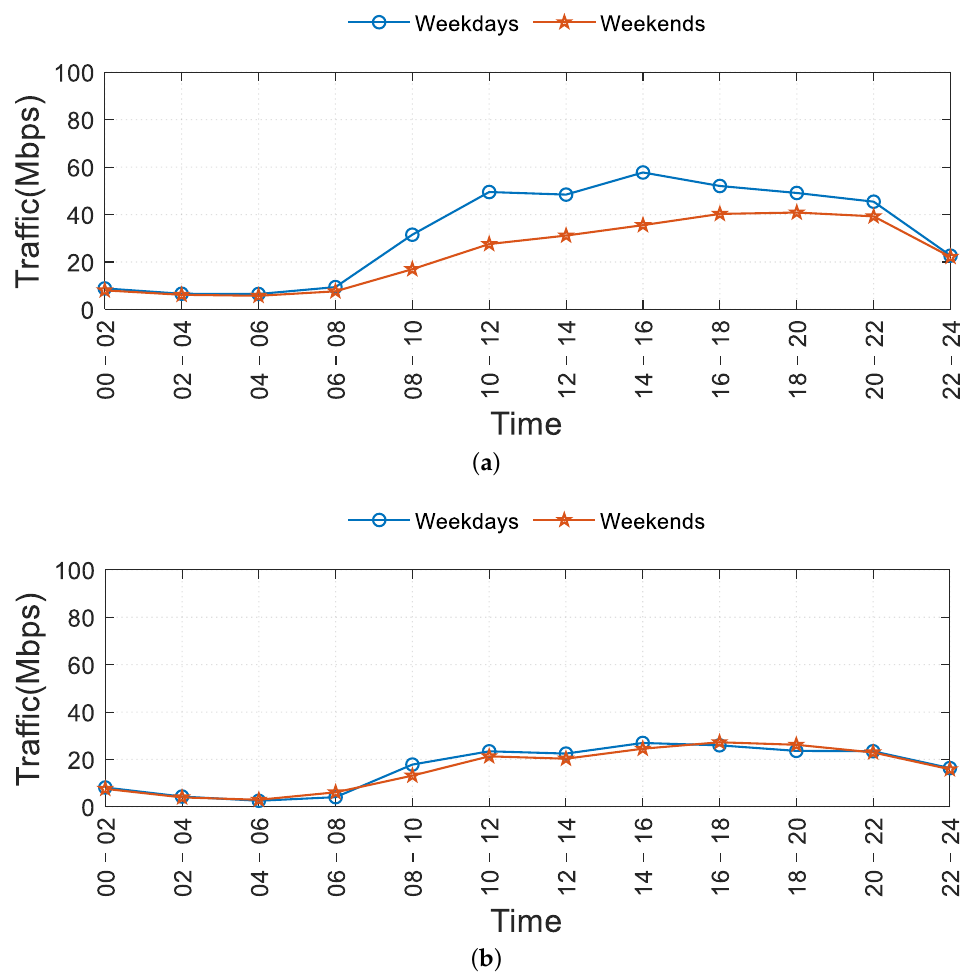
Figure 4. IPv6 upstream traffic patterns of weekdays and weekends. ( a ) Upstream traffic patterns in DHU. ( b ) Upstream traffic patterns in